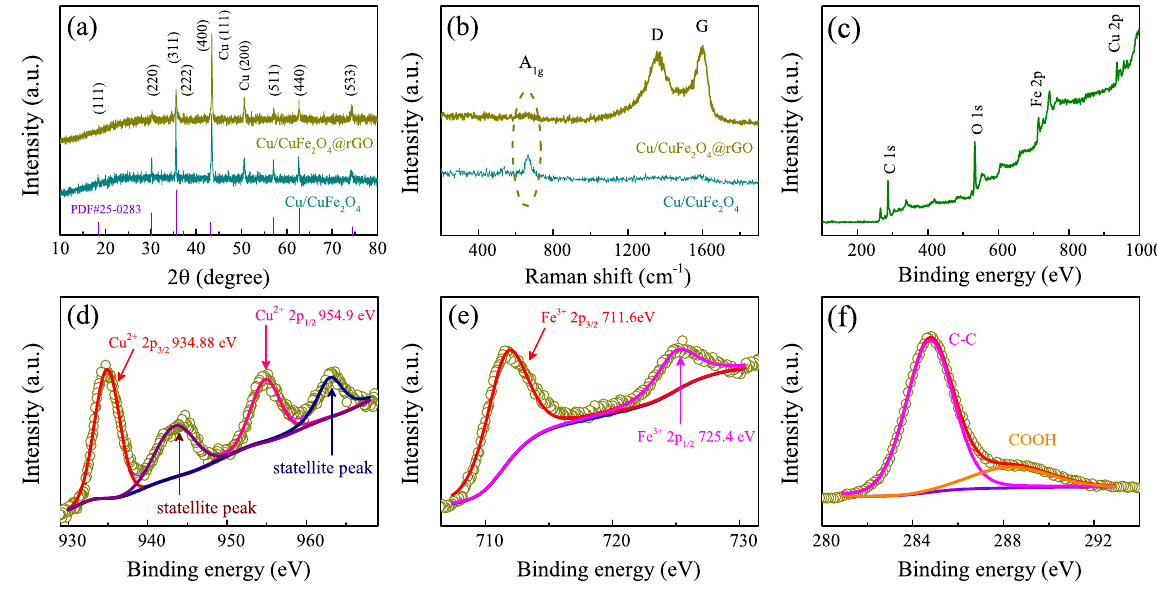
Figure 5. ( a ) XRD patterns and ( b ) Raman spectra of Cu/CuFe 2 O 4 and Cu/CuFe 2 O 4 @rGO. ( c ) XPS survey spectrum of